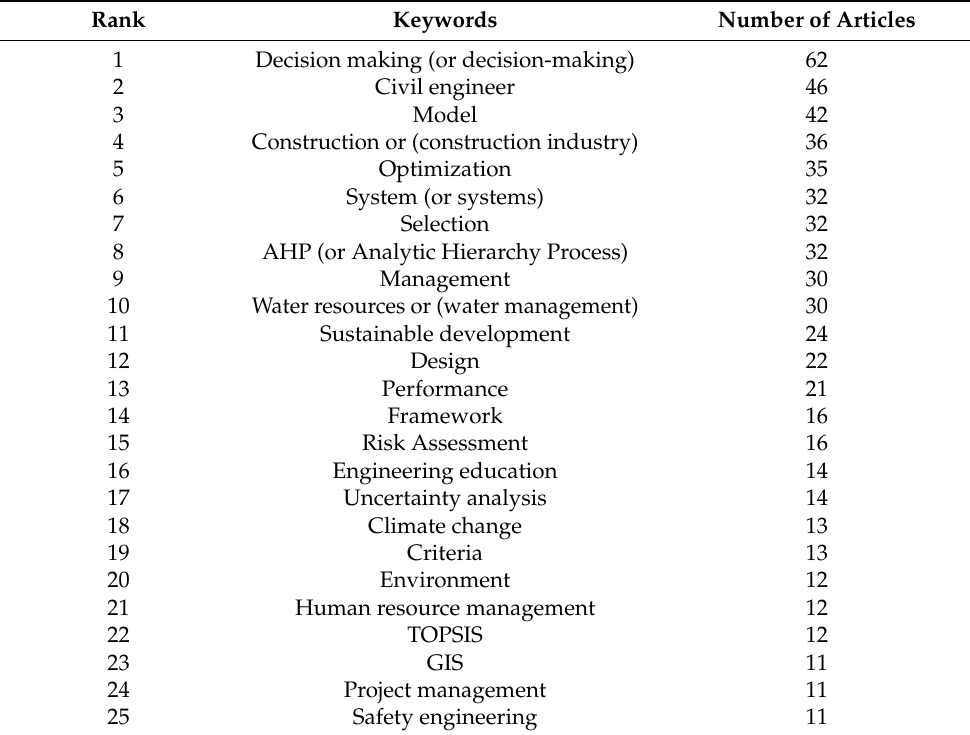
Table 2. Top 25 keywords in